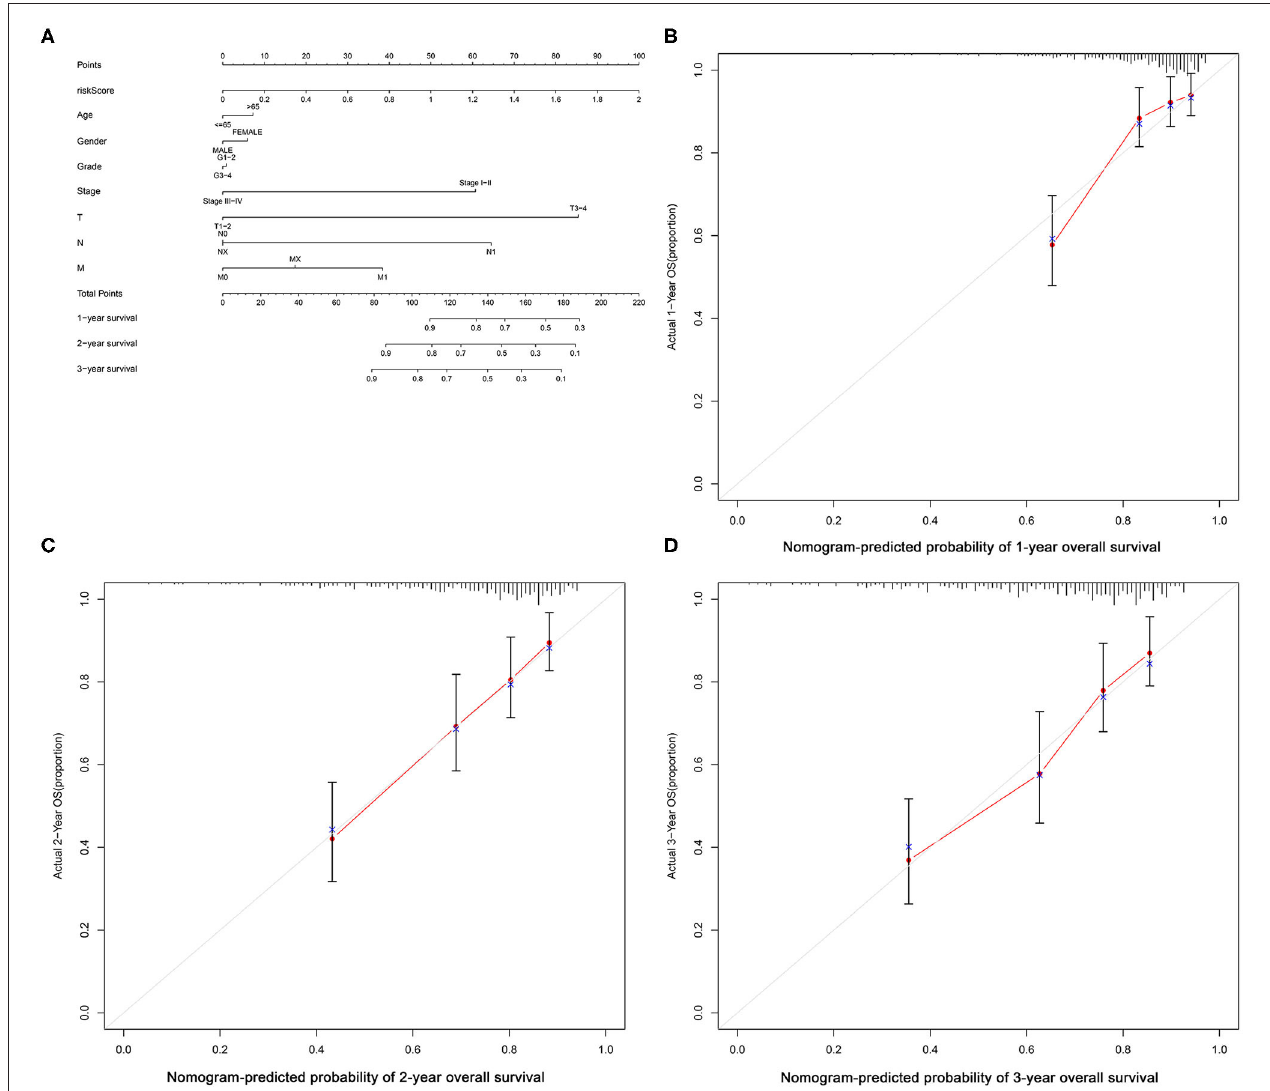
FIGURE 5 | Nomogram of the logistic regression model and calibration curves. (A) Nomogram; nomogram-predicted probability of (B) 1-year, (C) 2-year and (D) 3-year OS.